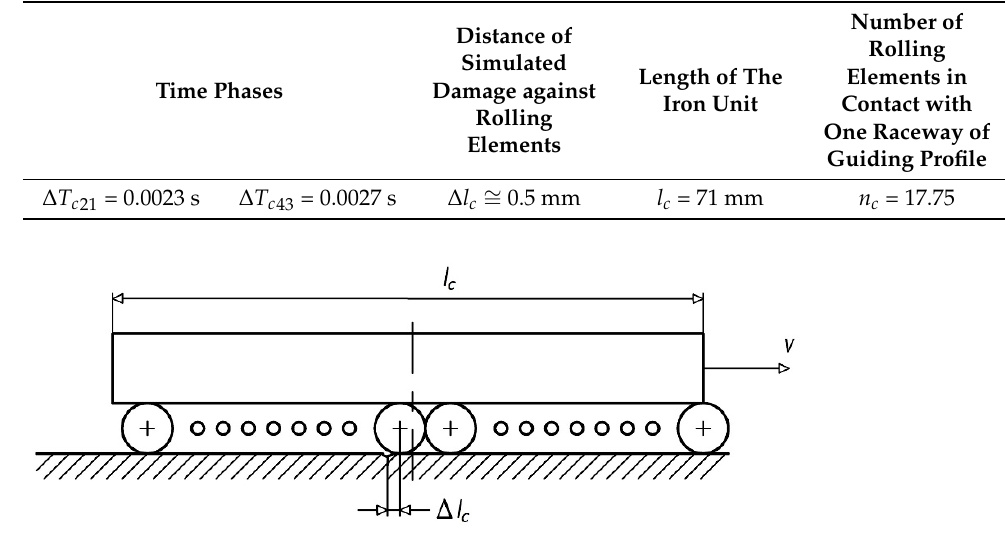
Figure 22. The position of the simulated damage against the rolling elements. Table 7. Results of Equations (17)–(20).